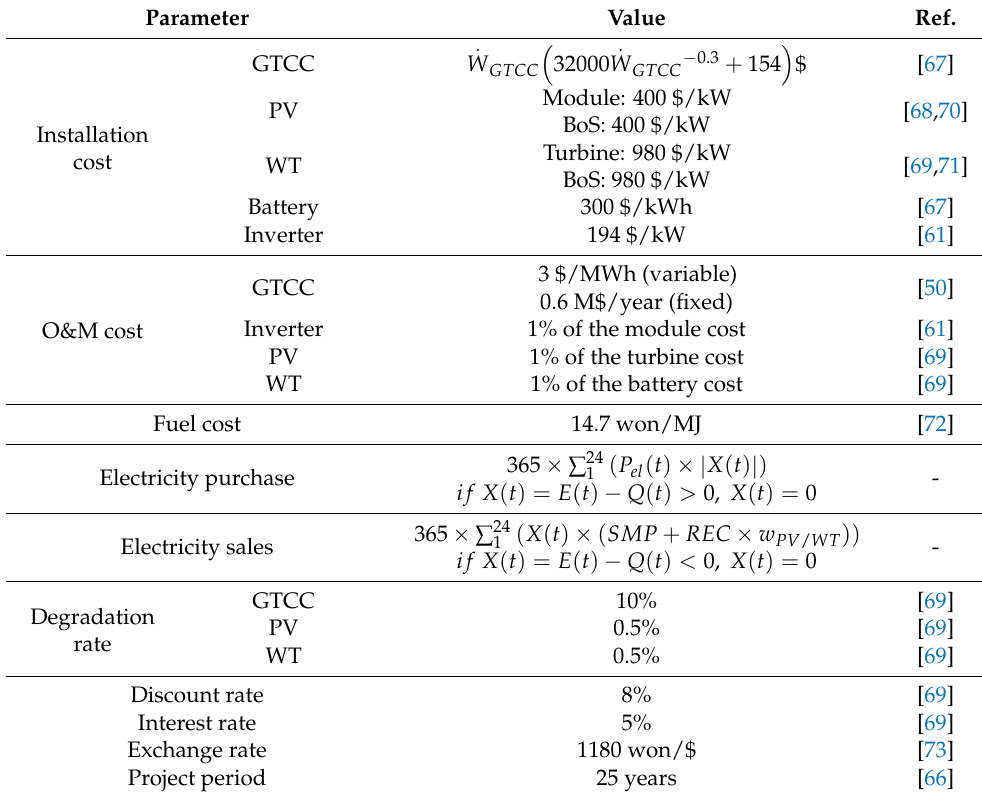
Table 7. Costs of each device for distributed generation